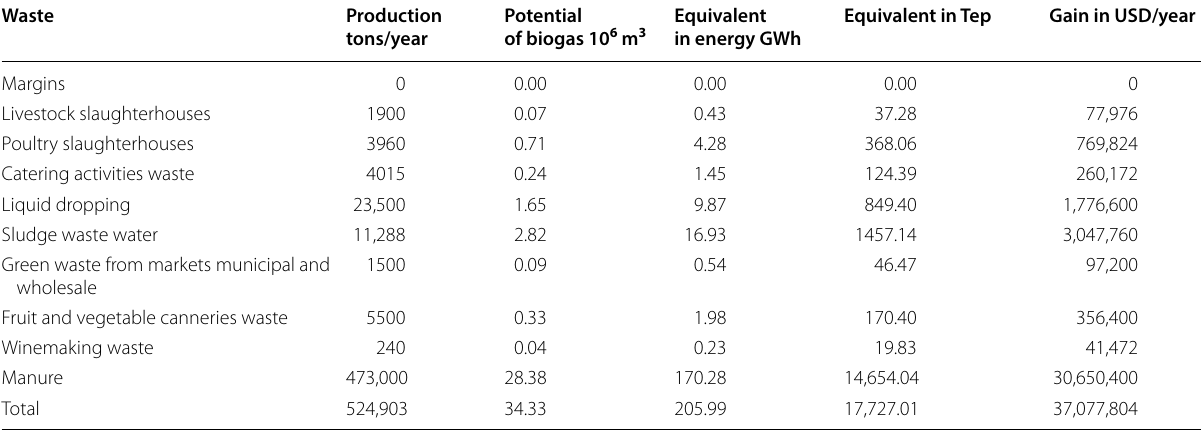
Table 5 Potential of biogas in the Mideast of